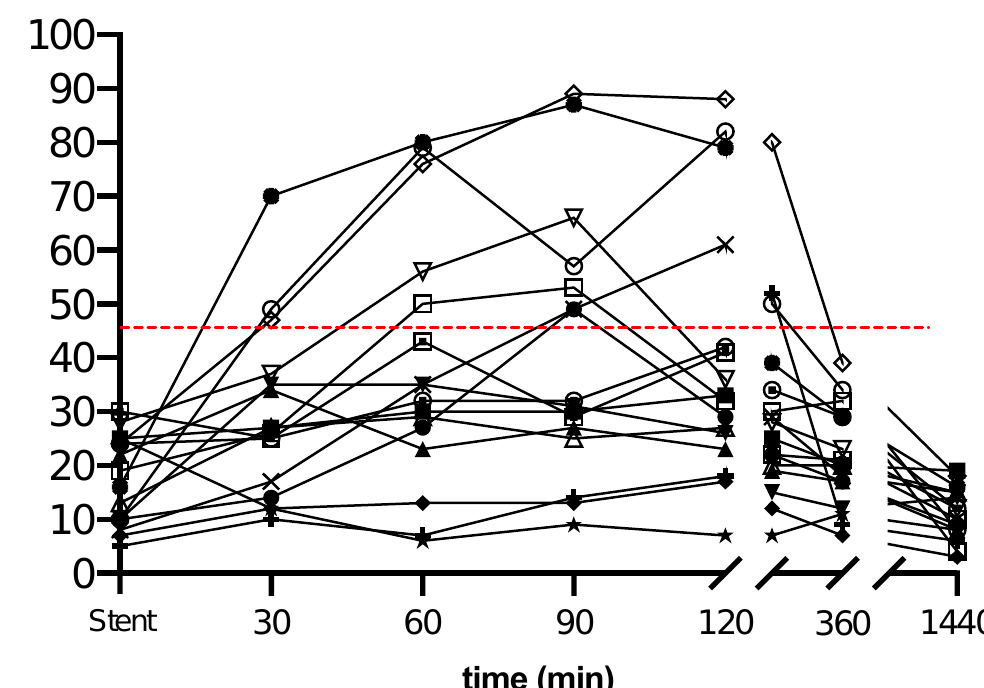
Figure 2. Platelet function from coronary stent placement (stent) to 24 h after end of cangrelor infusion (x-axis) was measured using whole blood aggregometry and is given in U (y-axis). Minutes 30 to 1440 refer to the time after cangrelor cessation. Cangrelor sufficiently inhibited P2Y12 at the time of coronary stent placement. Transitioning to ticagrelor within 39 min (IQR 5–50) before cangrelor cessation resulted in high platelet reactivity (HPR) in 44% (7/16) of patients within the first 90 min after end of cangrelor infusion. Red dashed line, HPR threshold of > 46U.